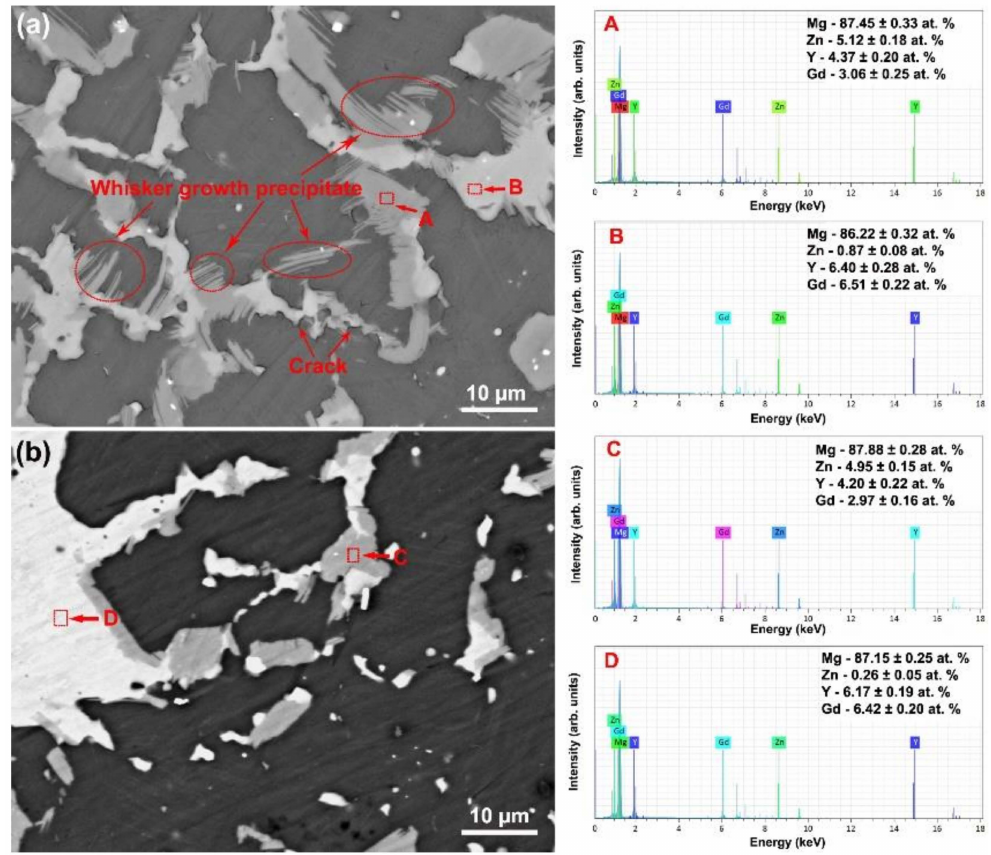
Figure 3. SEM surface images and EDS spectra of materials:( a ) M1, ( b ) M2, ( A ): point A in ( a ), ( B ): point B in ( a ), ( C ): point C in ( b ), ( D ): point D in ( b